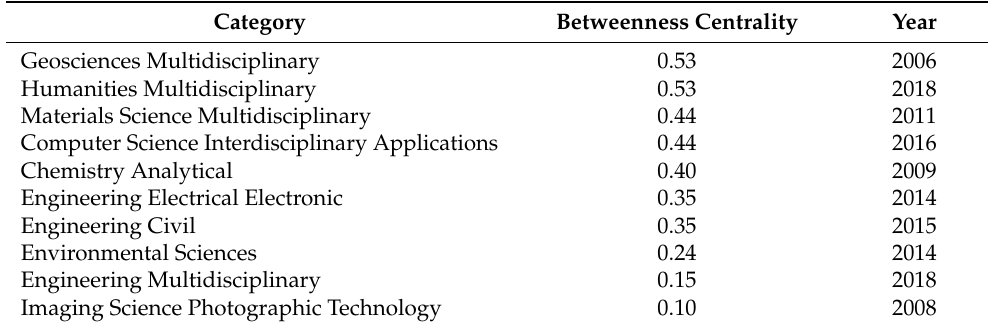
Table 5. The top ten categories based on the betweenness centrality in literature for the years 2006–2022. Category